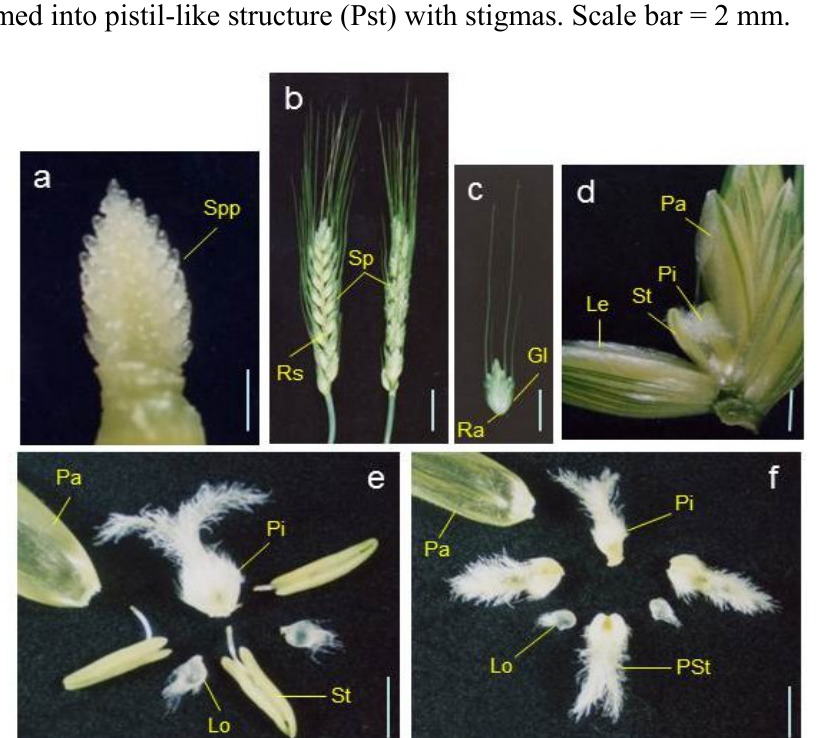
Figure 1. Wheat inflorescences and floral organs. ( a ) Developing young spike at the floret differentiation stage. The spikelet primordium (Spp) is indicated. Scale bar = 1 mm; ( b ) The wheat inflorescence (spike, ear, or head) is composed of spikelets (Sp) attached at the nodes of a zigzag rachis (Rs). Scale bar = 2 cm; ( c ) A spikelet that has been removed from the rachis. The spikelet consists of multiple (usually six to eight) florets attached at the rachilla (Ra). Two small bract leaves called glumes (Gl) enclose the spikelet. Scale bar = 1 cm; ( d ) A magnified image of an opened floret. In the floret, the reproductive organs, pistil (Pi) and stamens (St) are enveloped by two leaf-like structures, the lemma (Le) and the palea (Pa). The lemma and palea have been separated to make the reproductive organs visible in the figure. Scale bar = 2 mm; ( e ) An individual flower containing one pistil (Pi), three stamens (St) and two lodicules (Lo). The palea (Pa) is also indicated. In this figure, the pistil, stamens, lodicules and palea have been removed from the rachilla. Scale bar = 2 mm; ( f ) A flower from a plant of the pistillody line. The stamens are transformed into pistil-like structure (Pst) with stigmas. Scale bar = 2